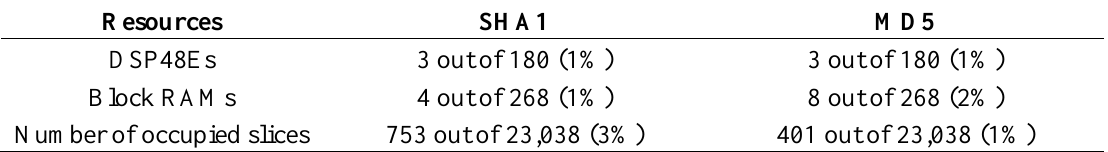
Table 1. Resource utilization of the different Encryption